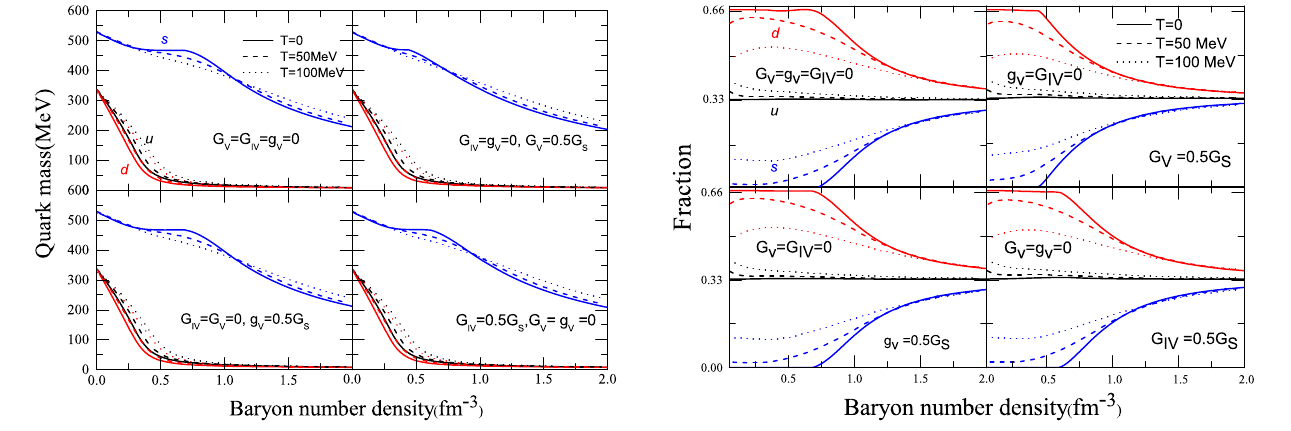
sion case ( g V = 0 . 5 G S , G V = G IV = 0), one can find that